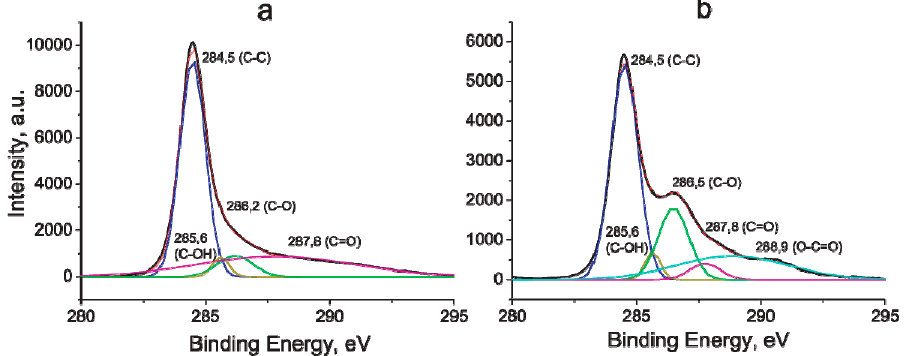
Figure 9. High-resolution carbon XPS spectra. ( a ) Initial MWCNT/Al sample. ( b ) Oxidized MWCNT/Al sample.